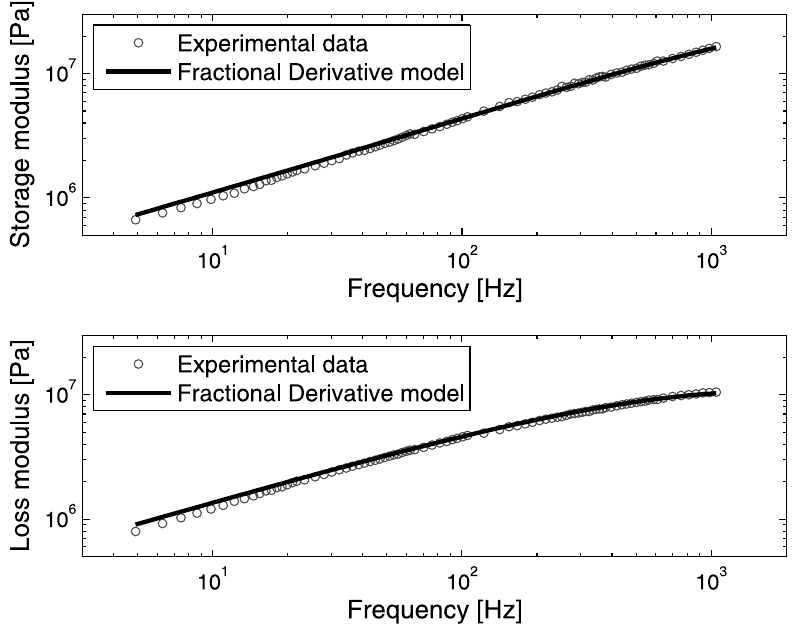
Fig. 7. Storage and loss modulus master curves representation for the fractional derivative